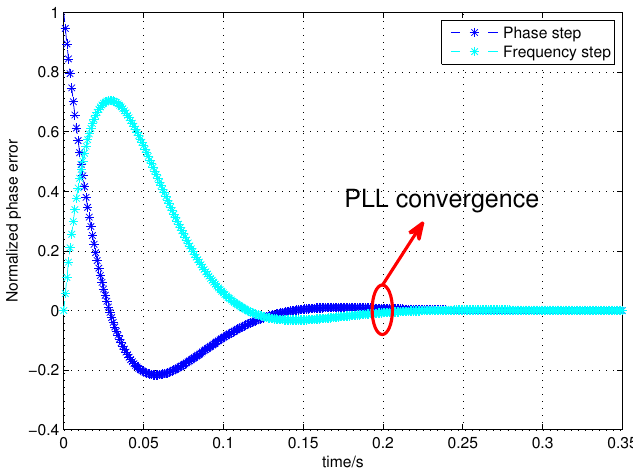
Figure 7. Error response of the frequency and phase step